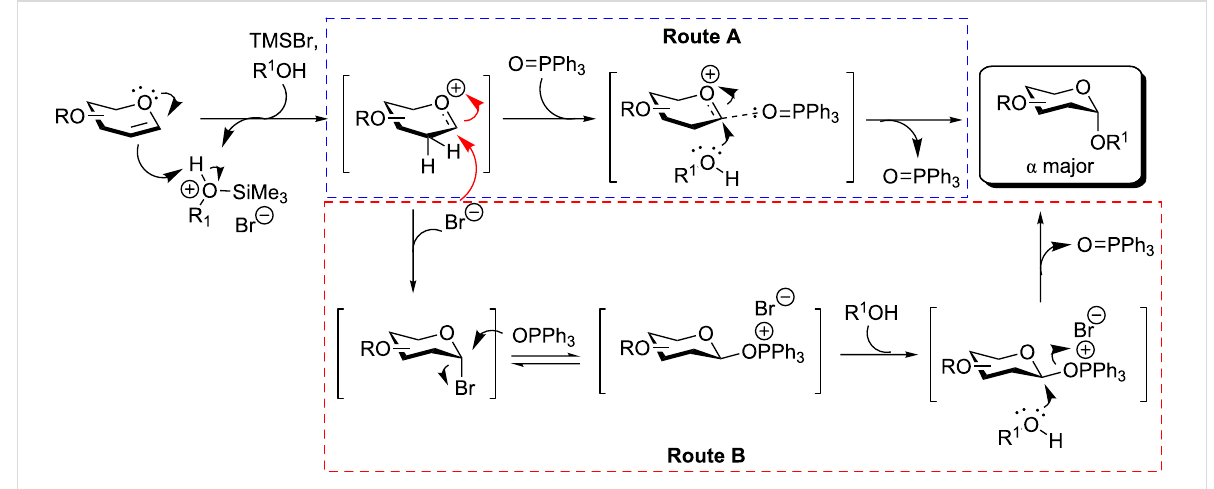
Scheme 2: Proposed mechanisms for TMSBr-mediated synthesis of 2-deoxyglycosides in the presence of TPPO.